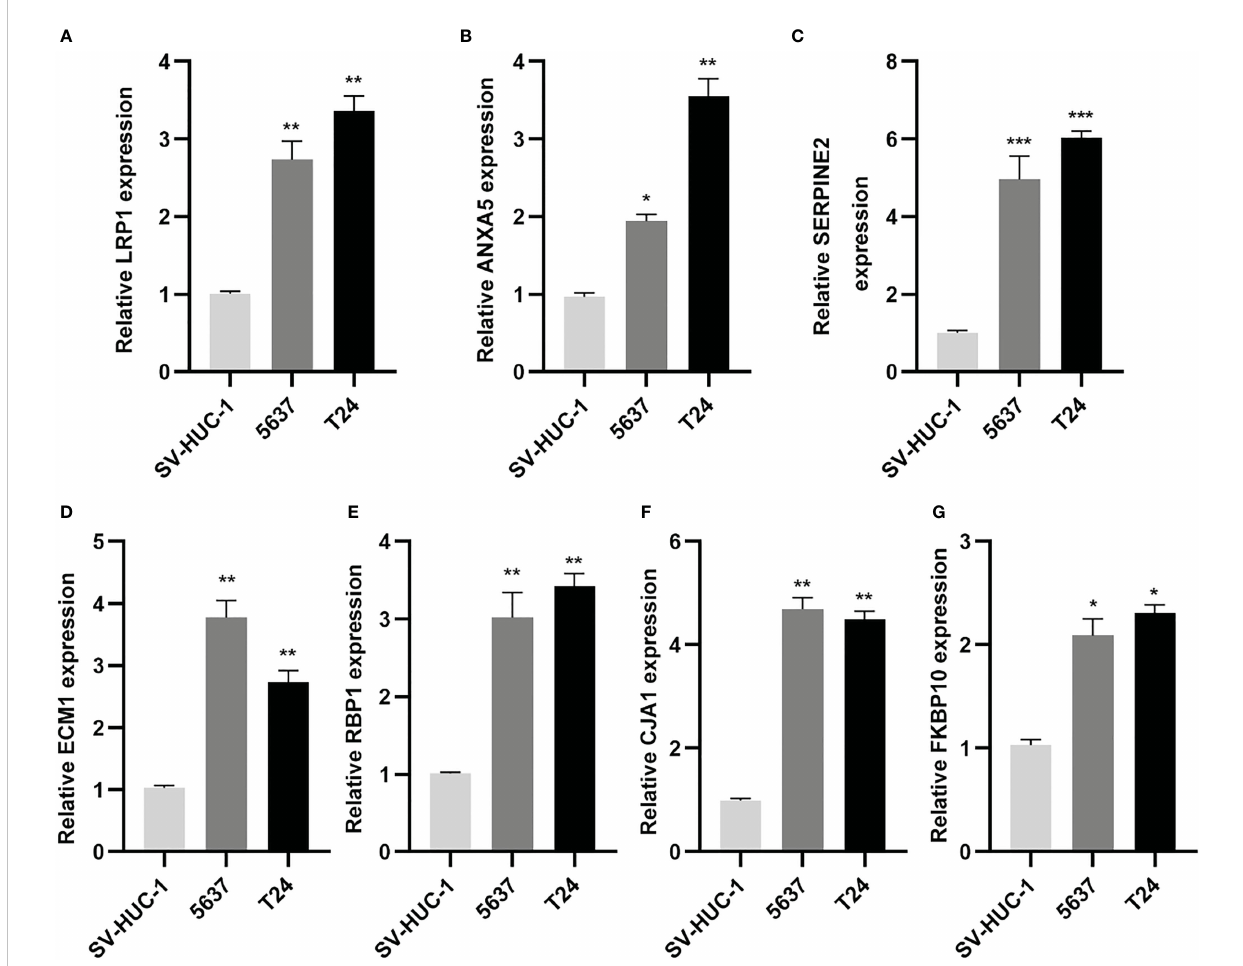
FIGURE 13 CAF-related genes were highly expressed in BLCA lines. (A-G) Relative expression of mRNAs (LRP1, ANXA5, SERPINE2, ECM1, RBP1, GJA1, FKBP10) in 2 BLCA cell lines (5637, T24) and SV-HUC-1 cell line was measured using qRT-PCR. *p< 0.05, **p< 0.01, and ***p<